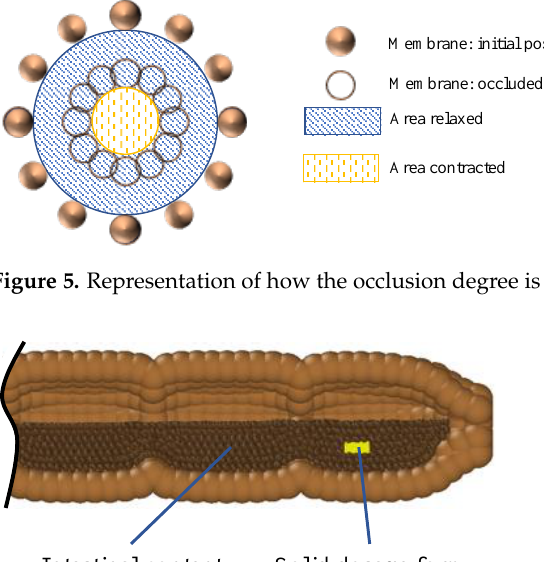
Figure 5. Representation of how the occlusion degree is defined.